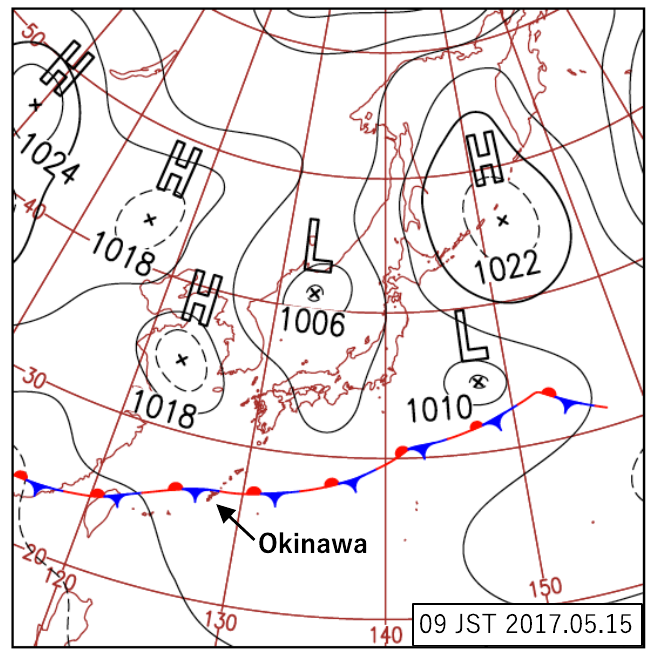
Figure 2. Surface weather chart from Japan Meteorological Agency at 09 JST on 15 May